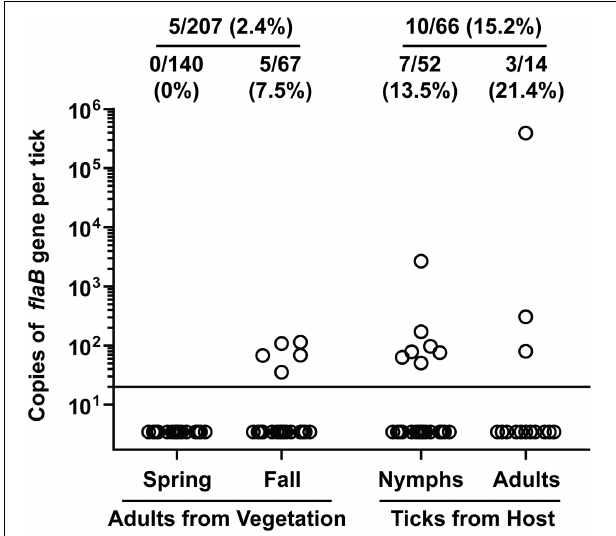
FIGURE 3 | Borrelia burgdorferi DNA burden in I. scapularis collected from Tiverton Township. Circles represent copies of the B. burgdorferi flaB gene in individual ticks. The ratio and percentage of samples tested positive were shown at the top of each group. The adult ticks collected from vegetation were divided into 2 groups depending on when they were collected, and the ticks collected from a host were divided into 2 groups according to their developmental